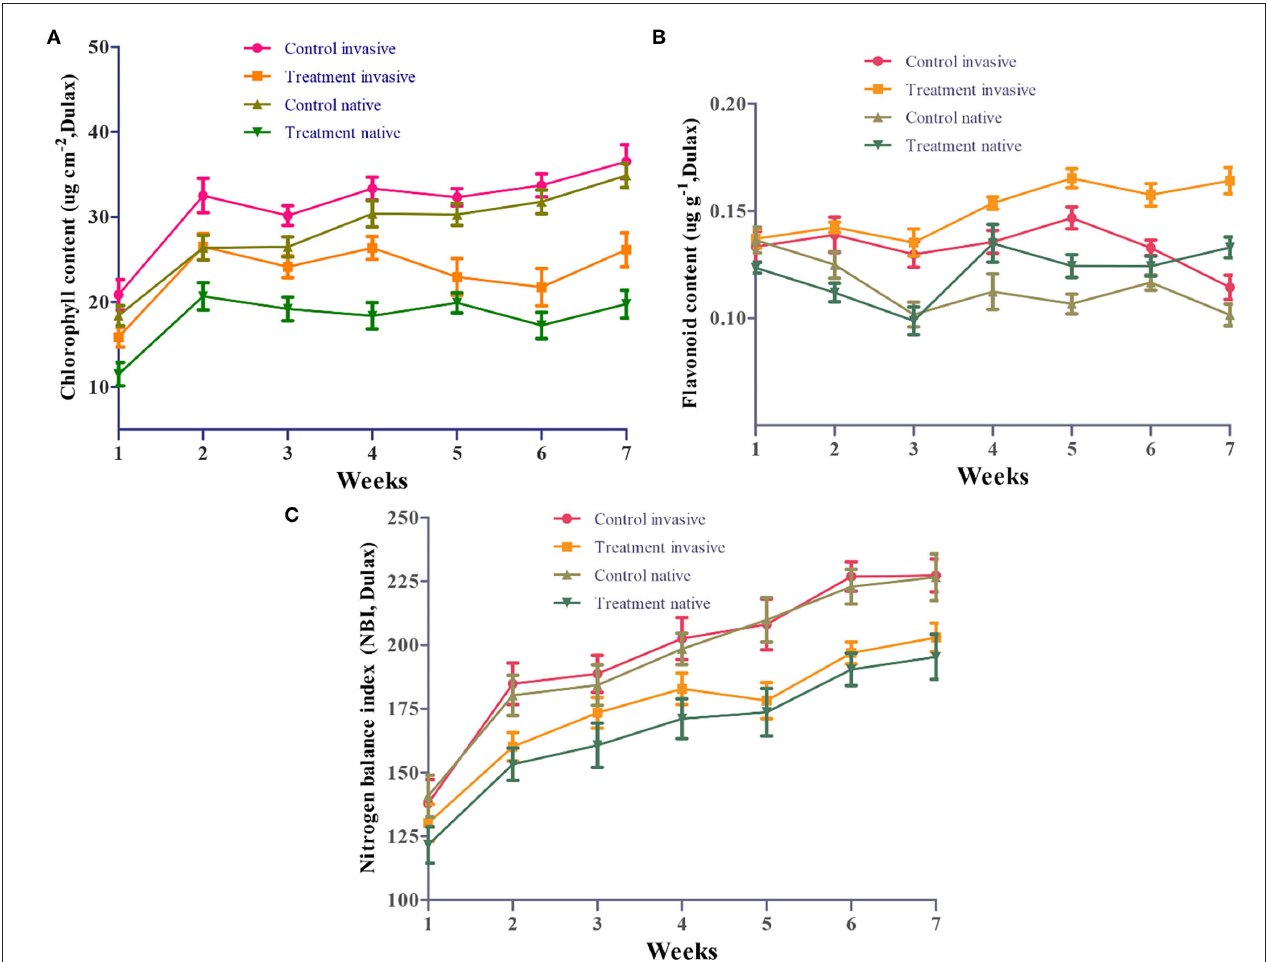
FIGURE 6 | Effect of cadmium (Cd) on chlorophyll content (A) , flavonoids content (B) and NBI (C) of leaves in invasive and native plants during stress conditions. Control: uncontaminated soil + native and invasive plants: Treatment Cd contaminated soil (80 mg/kg) + native and invasive. Error bars depict the SE of the mean of four independent